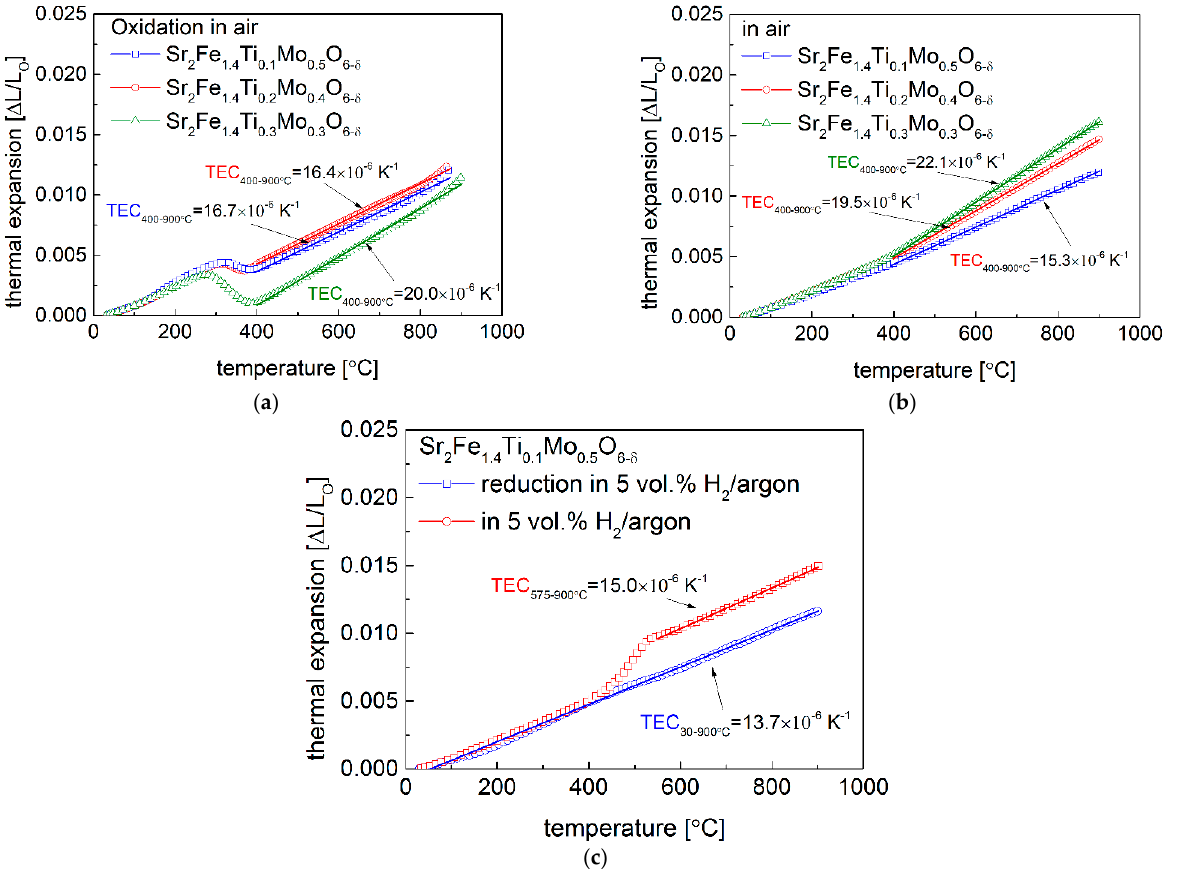
Figure 6. Thermal expansion behaviour of ( a ) oxidizing reduced Sr 2 Fe 1 . 4 Ti x Mo 0 . 6 − x O 6 −δ sinters in air; ( b ) oxidized Sr 2 Fe 1 . 4 Ti x Mo 0 . 6 − x O 6 −δ (x = 0.1, 0.2 and 0.3) samples in air; ( c ) reducing oxidized Sr 2 Fe 1 . 4 Ti 0 . 1 Mo 0 . 5 O 6 −δ and the reduced sample in 5 vol. % H 2 /argon.